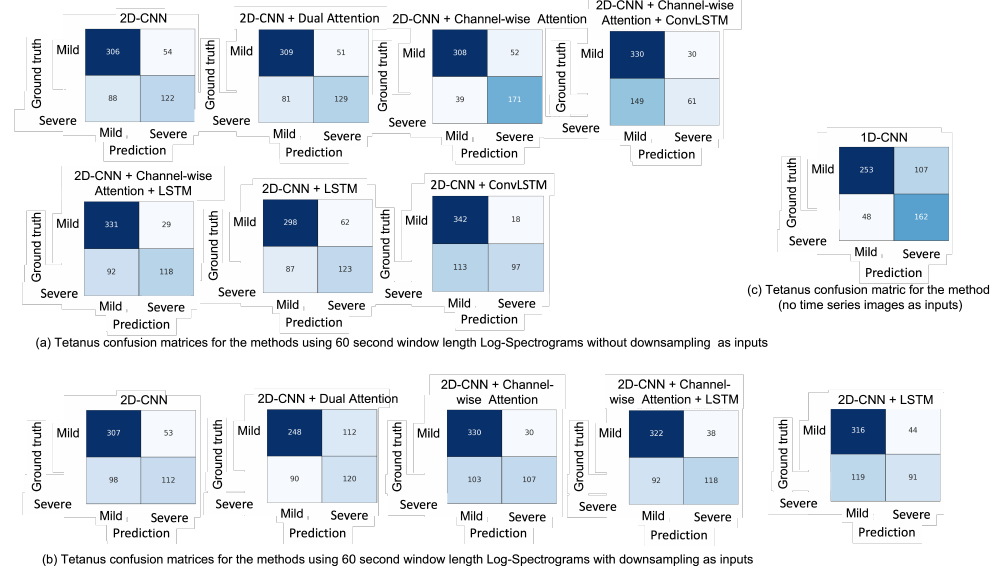
Figure 7. Confusion matrices of the tetanus severity level diagnosis using different deep learning methods: ( a ) tetanus confusion matrices for the methods using 60 s window length log-spectrograms without downsampling as inputs; ( b ) tetanus confusion matrices for the methods using 60 s window length log-spectrograms with downsampling as inputs; ( c ) tetanus confusion matrices for the 1D- CNN method (no time series images as inputs).